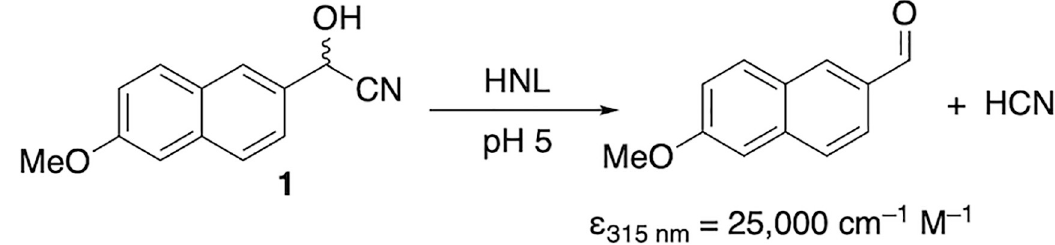
Fig 1. Colorimetric assay for hydroxynitrile lyase activity. Cleavage of cyanohydrin 1 yields an aldehyde that absorbs light strongly at 315 nm.